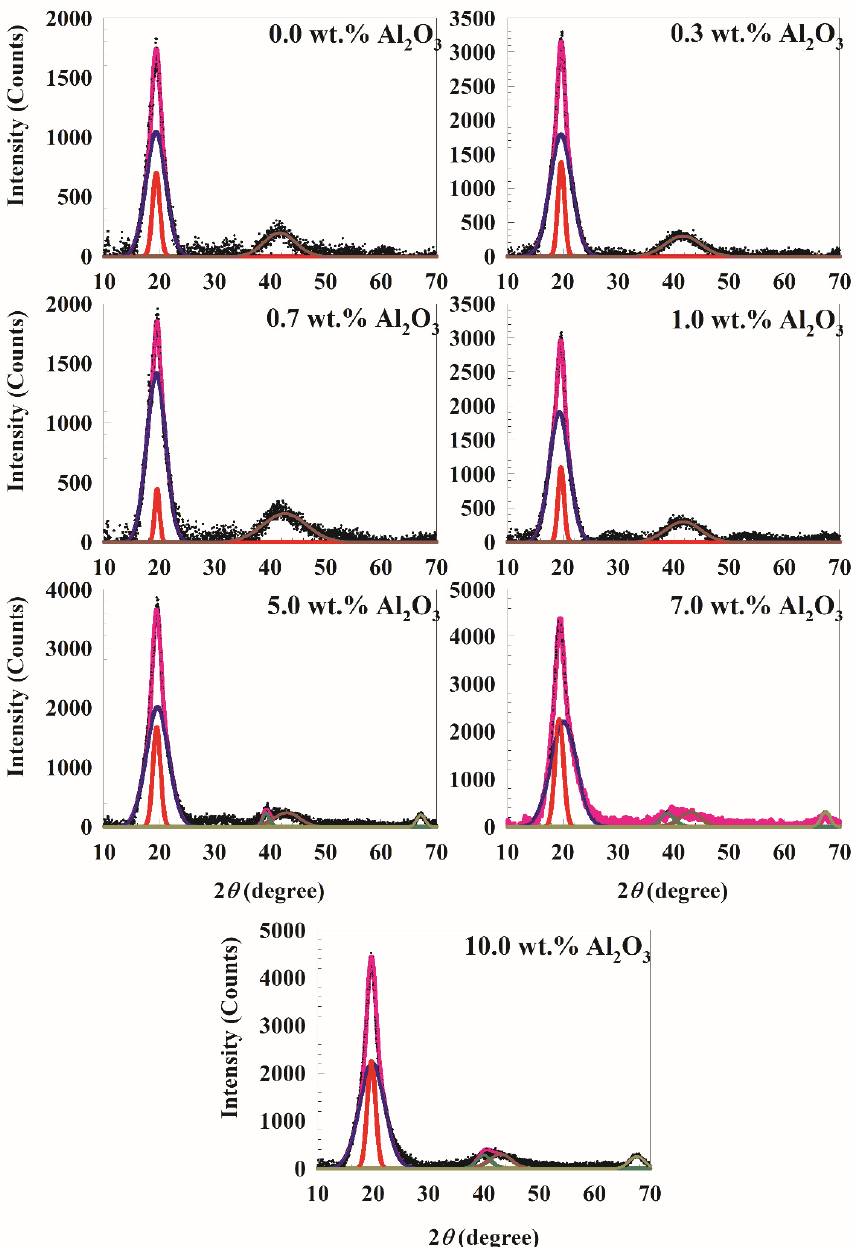
Figure 2. WAXD spectra for PVA/10 wt.% PEG/20 wt.% SSA membranes with different concentrations of Al 2 O 3 . The red peak presents the crystalline matter while the blue peak presents the amorphous matter in the PVA. In addition, dark yellow and dark red represent the peaks for Al 2 O 3 . The grain size D was calculated by applying the Scherrer equation [15]: 0.9(cid:2019) (cid:1830) = . (cid:2010)cos((cid:2016)) where λ is the wavelength, and β is the full width at half maximum (FWHM). Table 1 lists the peak position, FWHM, grain size, and area under the peak for crystalline and amorphous